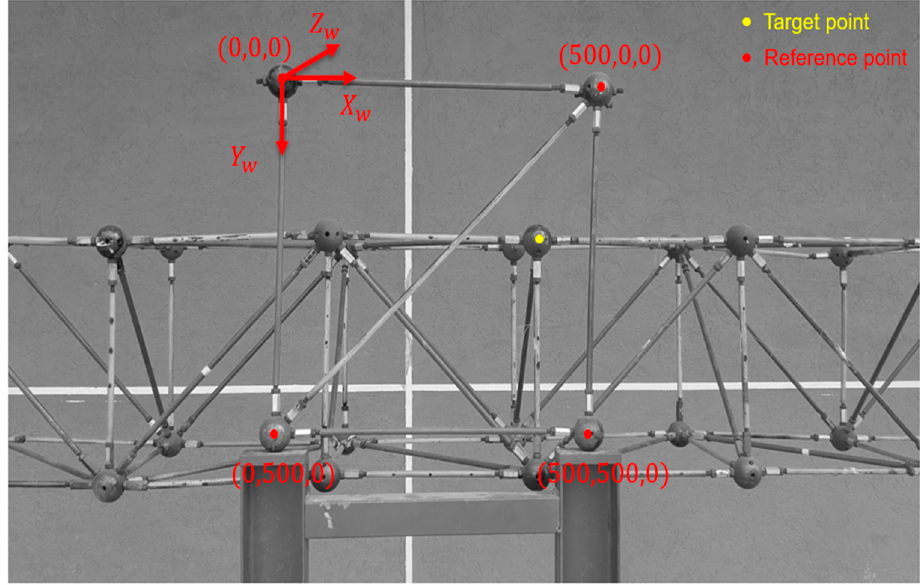
Figure 8. World coordinate system.